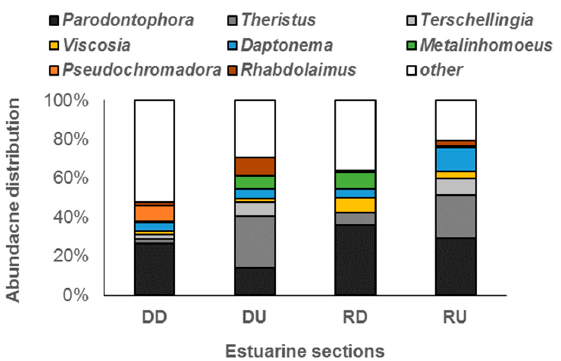
Figure 6. The percentage of the eight most abundant genera in each “estuarine section” (DD, DU, RD and RU), as identified by the SIMPER analysis. Abbreviations: “DD” = dammed downstream, “DU” = dammed upstream, “RD” = reference downstream, “RU” = reference upstream.